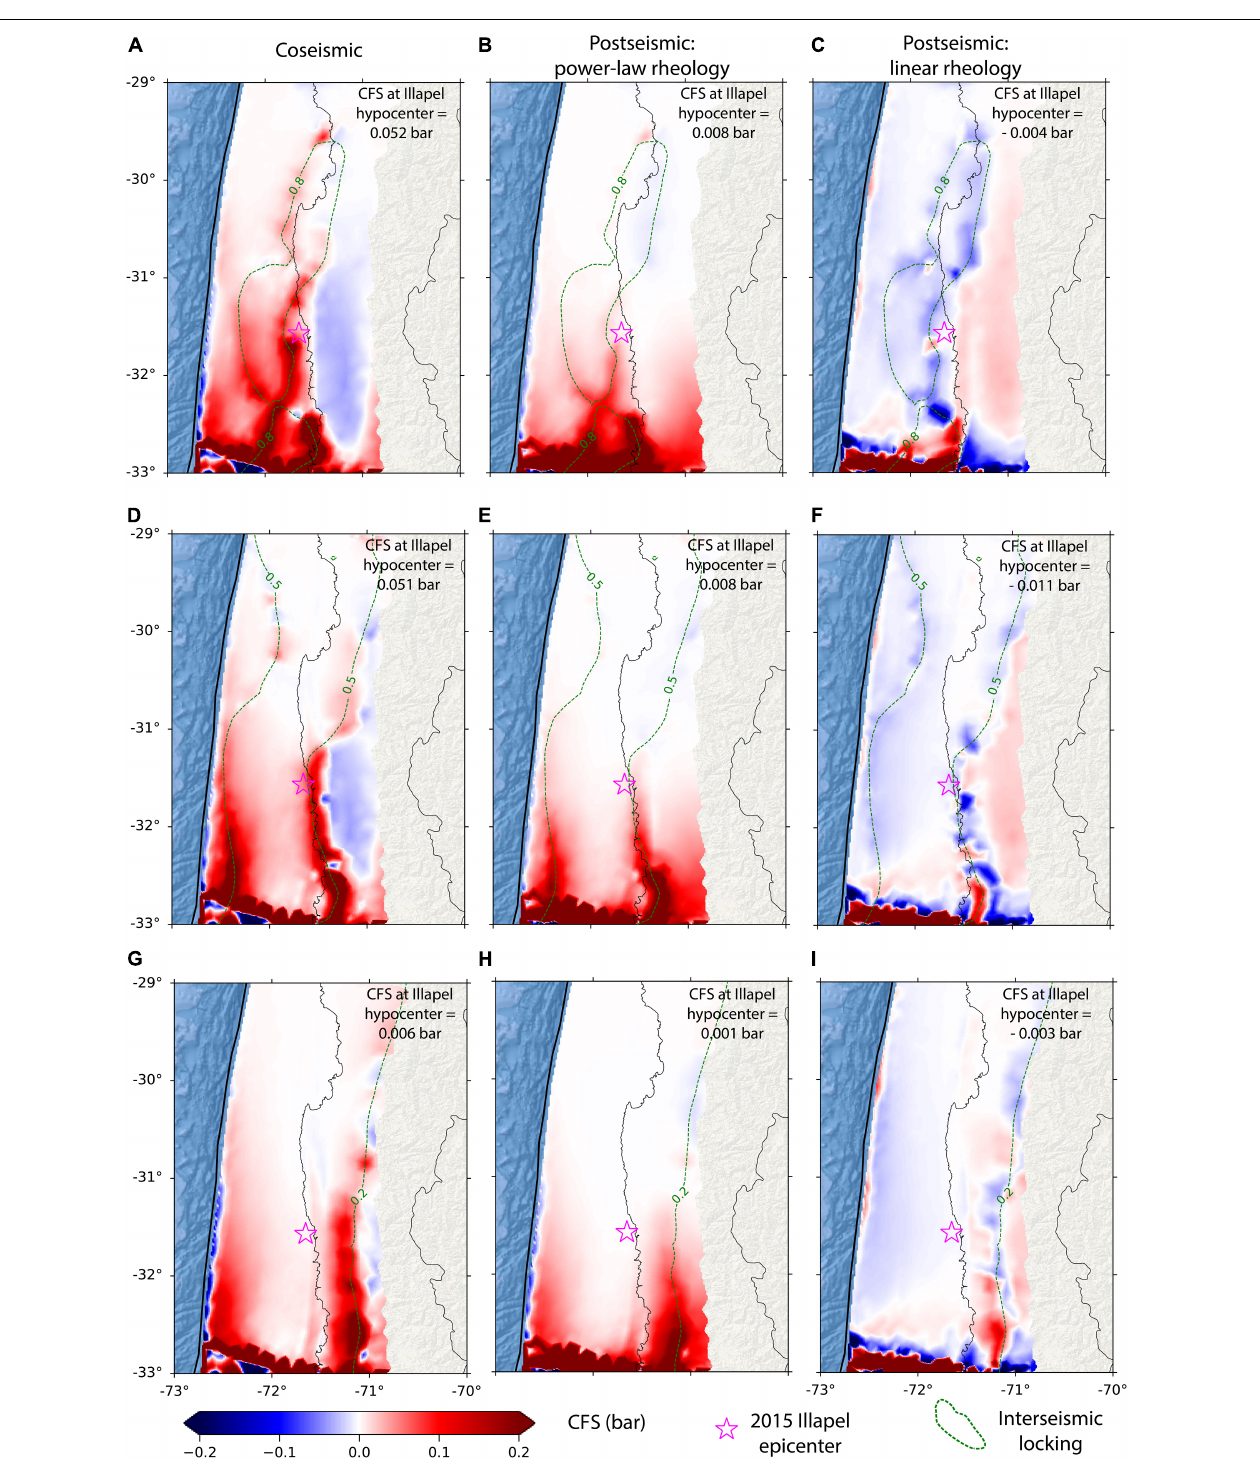
FIGURE 3 | Coulomb Failure Stress (CFS) changes resolved onto the fault interface from the modeled coseismic (left column) and postseismic deformation using power-law (middle column) and linear rheology (right column) in the Illapel segment (location given as the black-dashed rectangle in Figure 2 ). CFS changes are calculated using focal mechanism parameters of the 2015 Illapel mainshock with a strike of 353 ◦ , a dip of 19 ◦ , and a rake of 83 ◦ . (A–C) (upper row) are from scenario I ( µ (cid:48) = 0.04 in regions of locking ≥ 0.8 and µ (cid:48) = 0.01 in regions of locking < 0.8). (D–F) (middle row) are from scenario II ( µ (cid:48) = 0.04 in regions of locking ≥ 0.5 and µ (cid:48) = 0.01 in regions of locking < 0.5); and (G–I) are from scenario III ( µ (cid:48) = 0.04 in regions of locking ≥ 0.2 and µ (cid:48) = 0.01 in regions of locking < 0.2). The locking region ≥ 0.2 in (G–I) is the one between the dashed-green line and the trench (solid-black line).